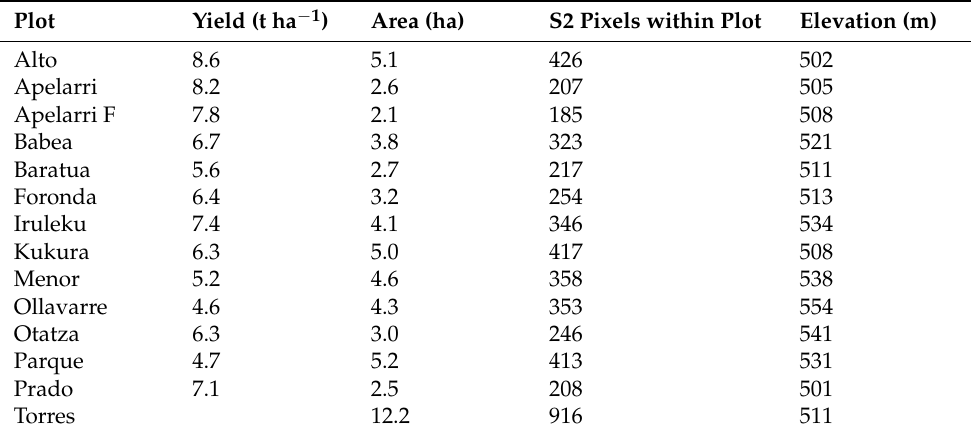
Table 1. Average plot yield, area, number of Sentinel-2 pixels, and